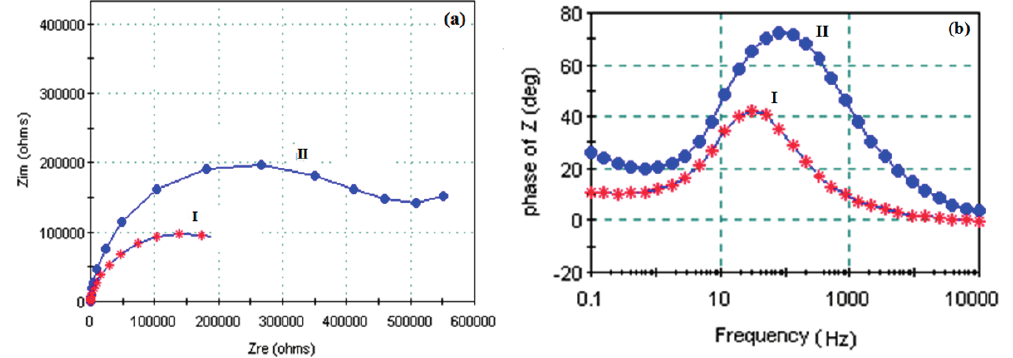
Figure 4. Electrochemical impedance spectra ( a ) Nyquist; ( b ) Bode Phase.